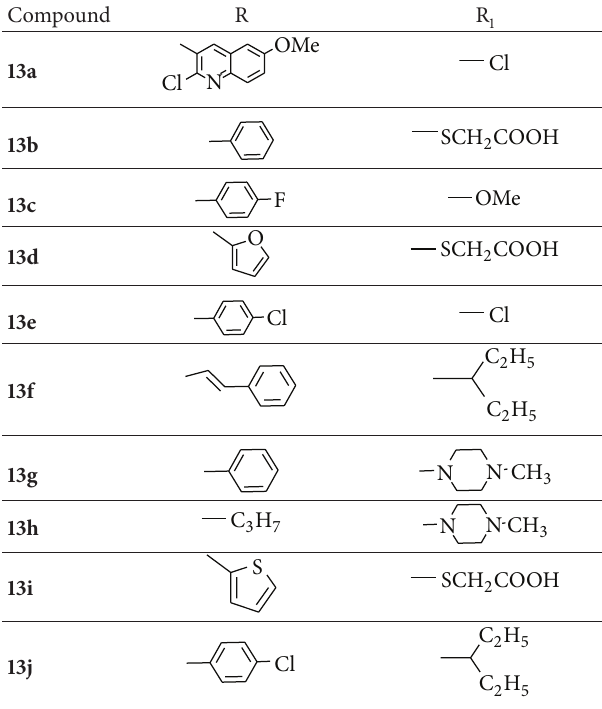
Table 6: List of compounds tested.